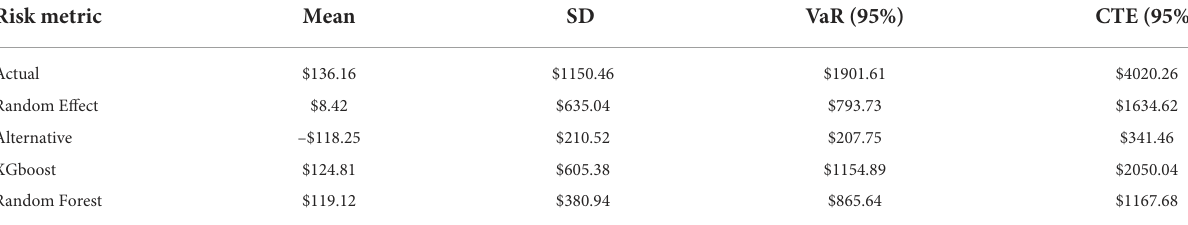
TABLE 9 Premium deficiency for unearned premium risk under each model.